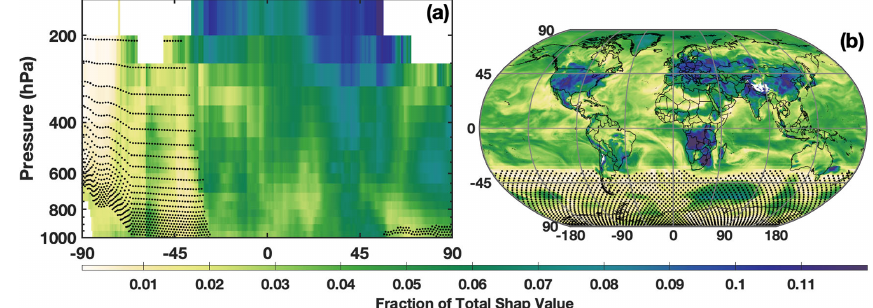
Figure 7. The fraction of the contribution of the NO 2 SHAP value to the sum of the absolute SHAP value of all inputs in July is shown for the zonal mean (a) and the LFT (b) . Regions where mean OH mixing ratios are below 0.03pptv, the point below which the untuned parameterization is unable to reasonably predict OH, are indicated by the